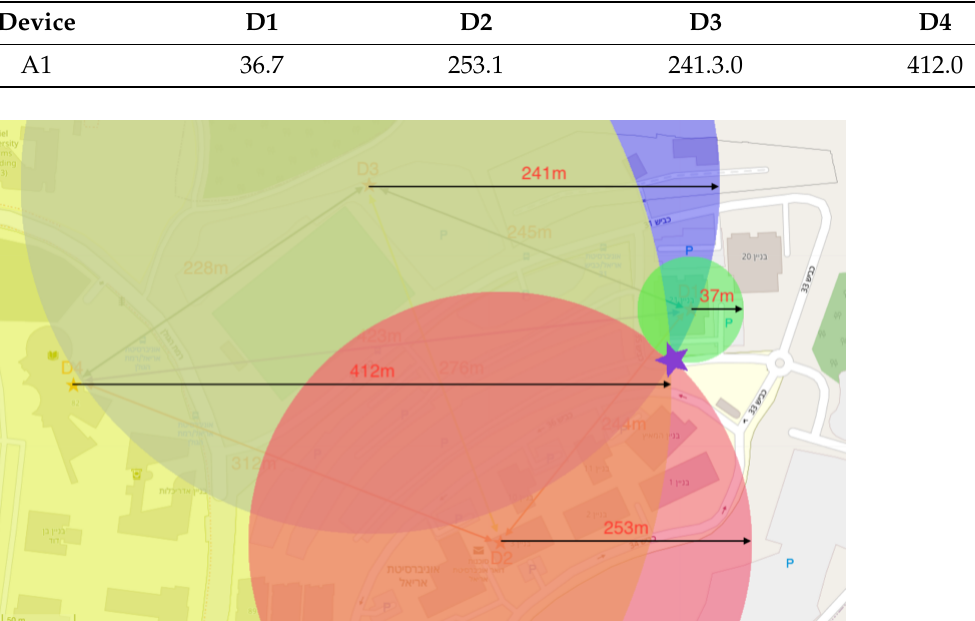
Table 4. Node distance measurement results.